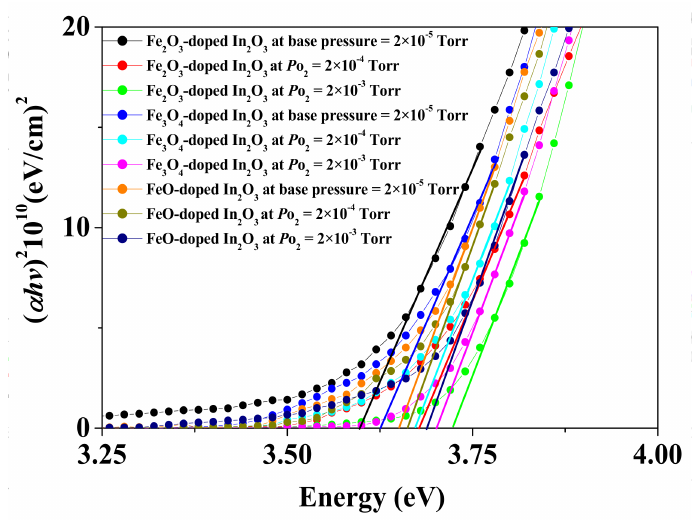
Figure 6. Absorption data of Fe-doped In 2 O 3 samples grown from FeO, Fe 3 O 4 and Fe 2 O 3 precursors deposited at a base pressure of 2 × 10 − 5 Torr and the two higher oxygen pressures of 2 × 10 − 4 Torr and 2 × 10 − 3 Torr.